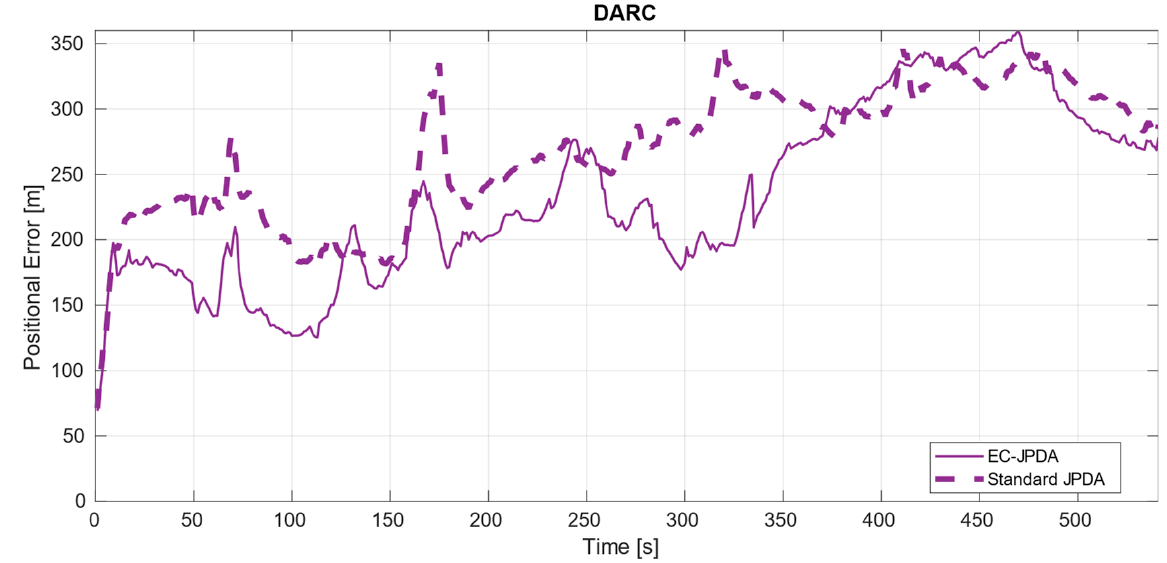
Figure 8. Error of Target 2, a large vessel, in DARC.